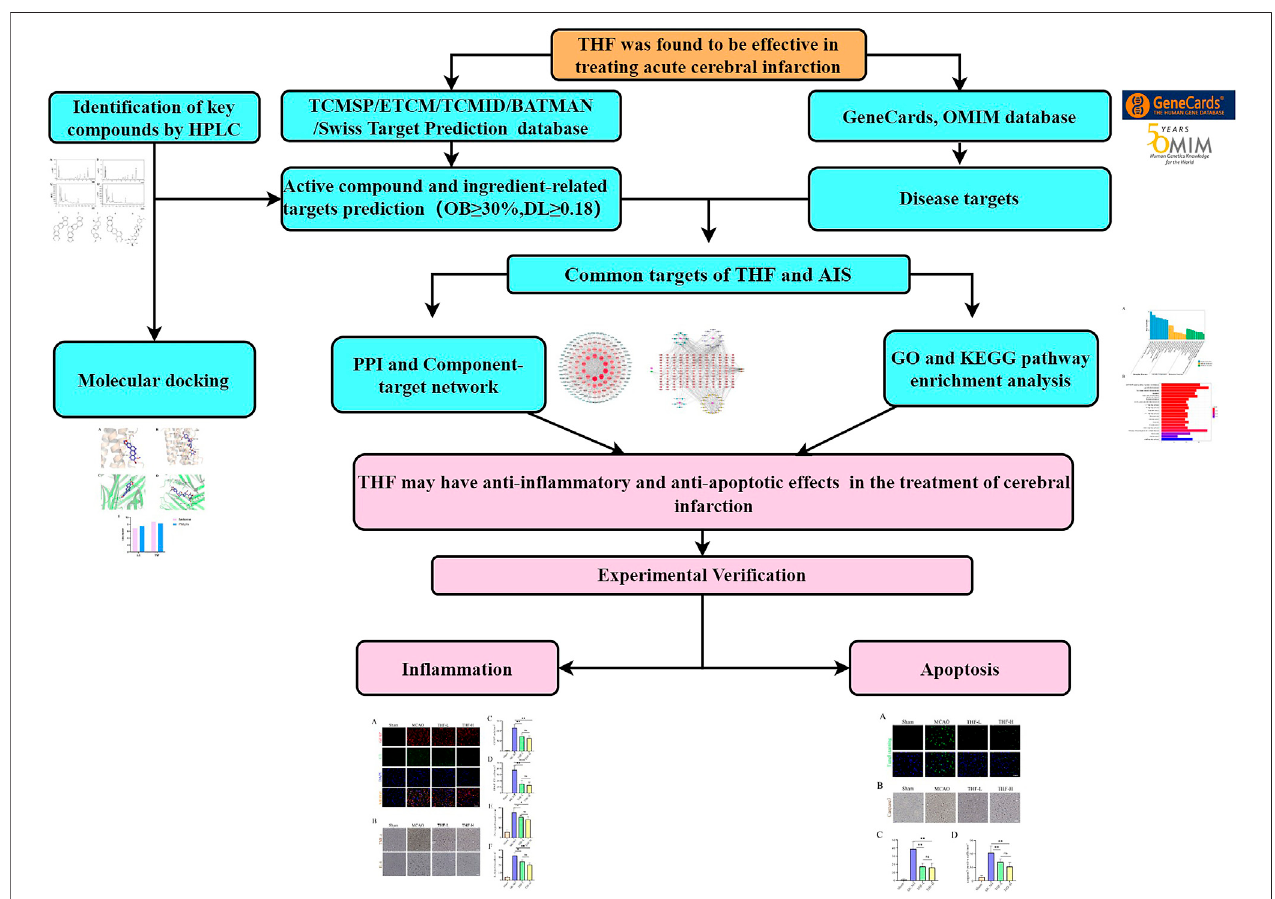
FIGURE 1 | Framework of this